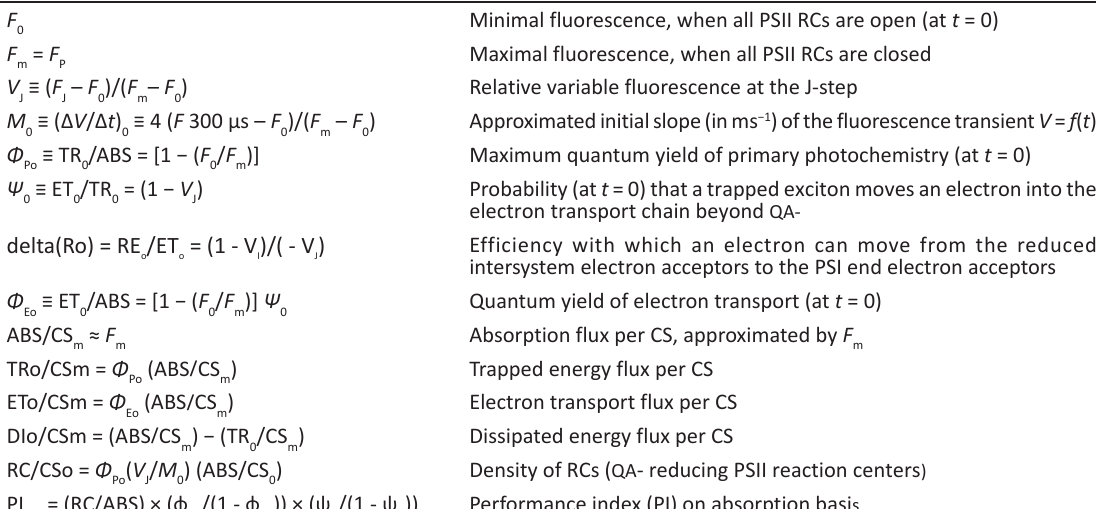
Minimal fluorescence, when all PSII RCs are open (at t = 0) Maximal fluorescence, when all PSII RCs are